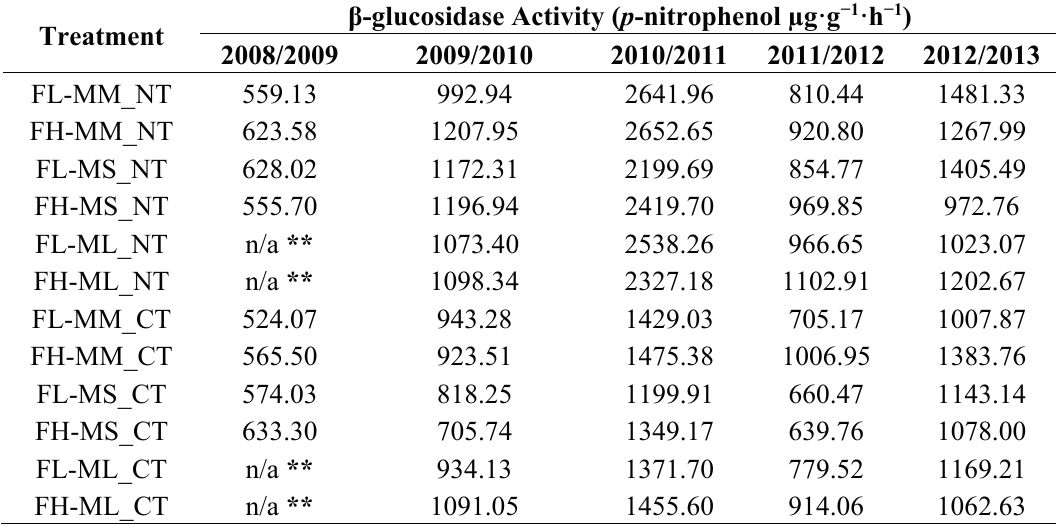
Table A3. The mean activity levels of three soil microbial enzymes over a period of five seasons (2008/2009 to 2012/2013) under different agricultural